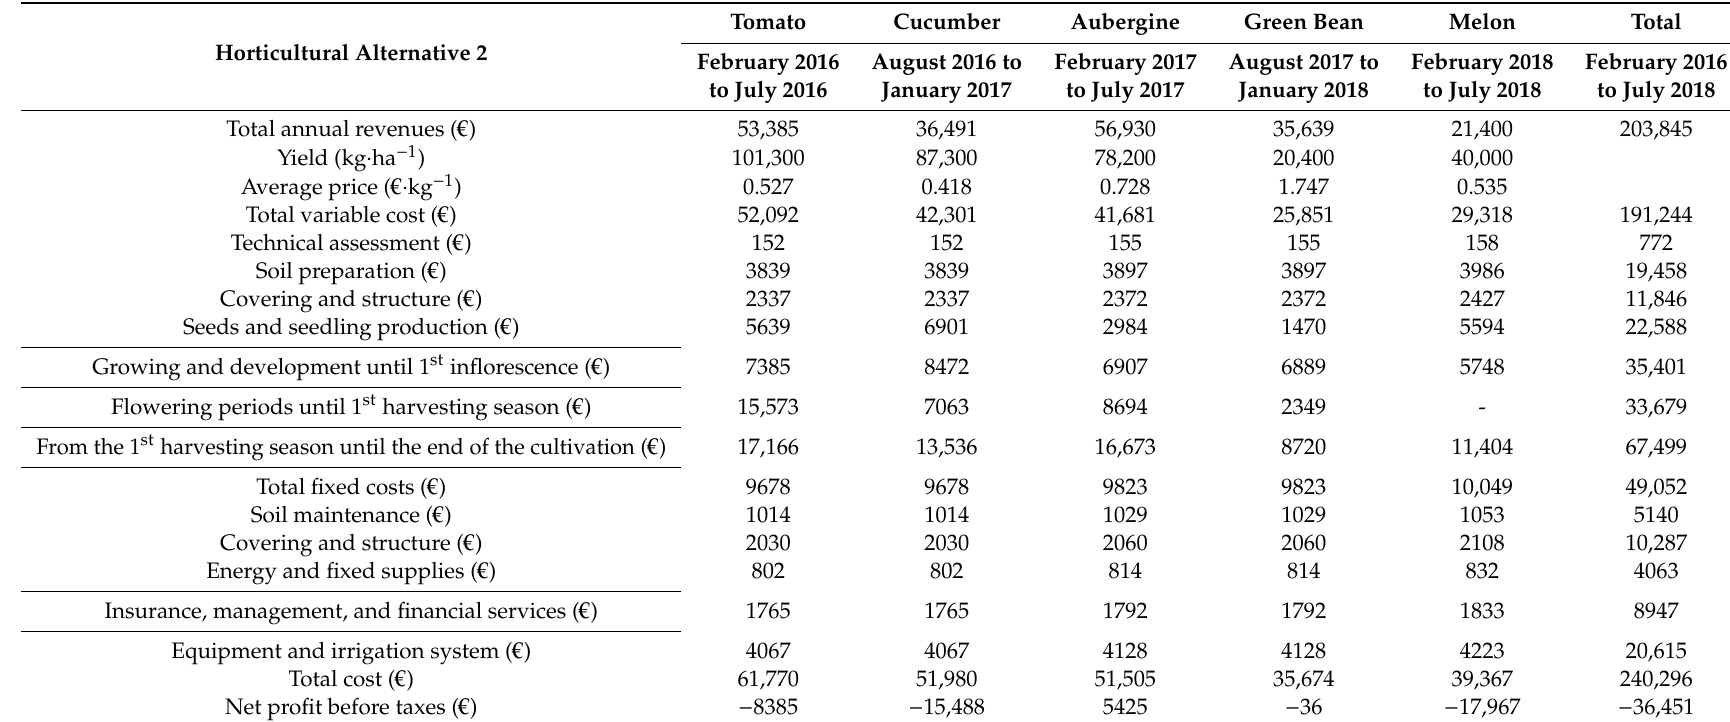
Table A4. Revenues and expenses per hectare imputed to the cultivation of the horticultural alternative 2 in a 30-month cycle (2016–2018).